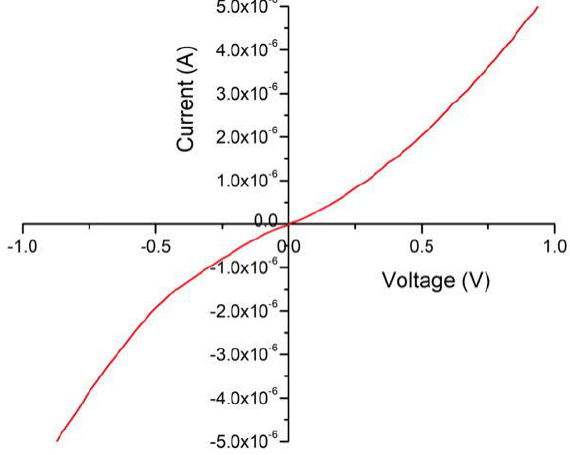
Figure 2. Example of an I-V measurement curve for Nanocomp YE-A10 CNT fiber as measured with two tungsten probes 20 µ m apart in an Omicron nanoprobe using a voltage sweep from − 1 to +1 V.